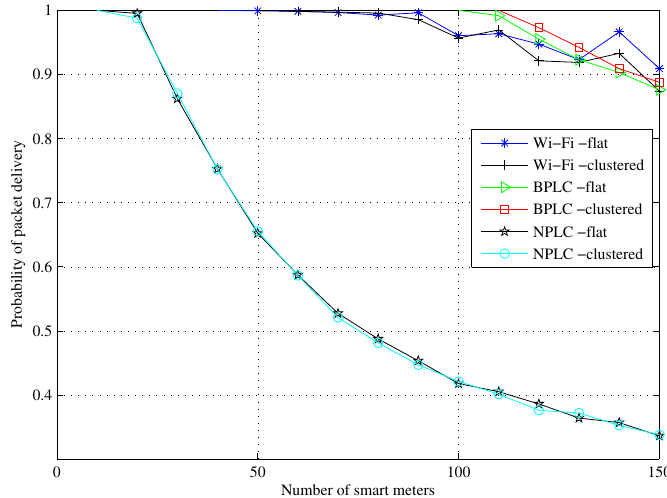
Figure 10. Probability of packet delivery (PPD) of flat and clustered advanced metering infrastructure